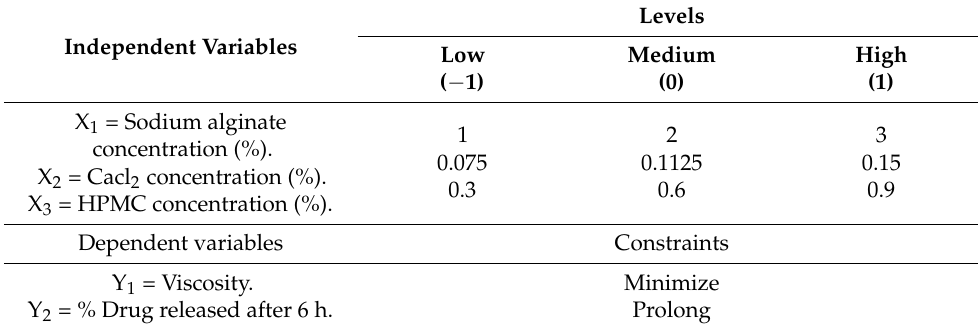
Table 3. Variables and their levels in the 3 3 factorial